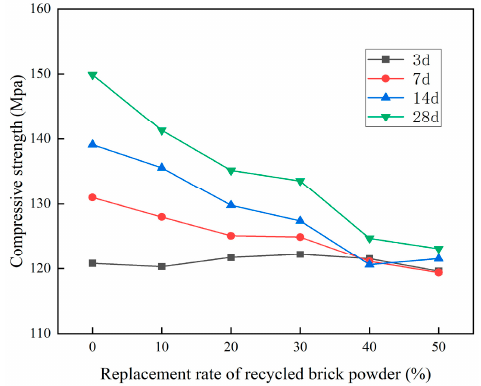
Figure 7. Drying shrinkage test.